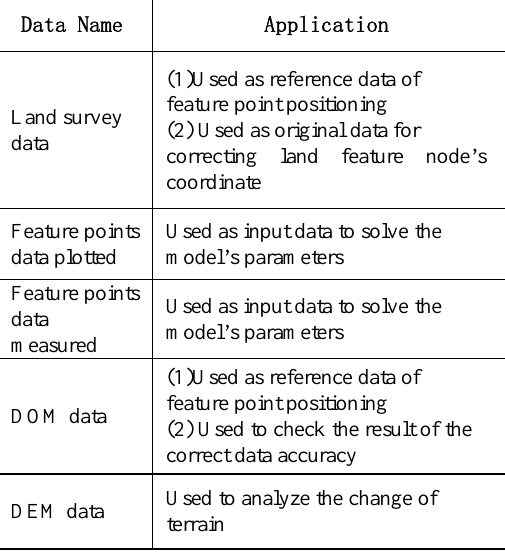
Table1: data preparation content summary